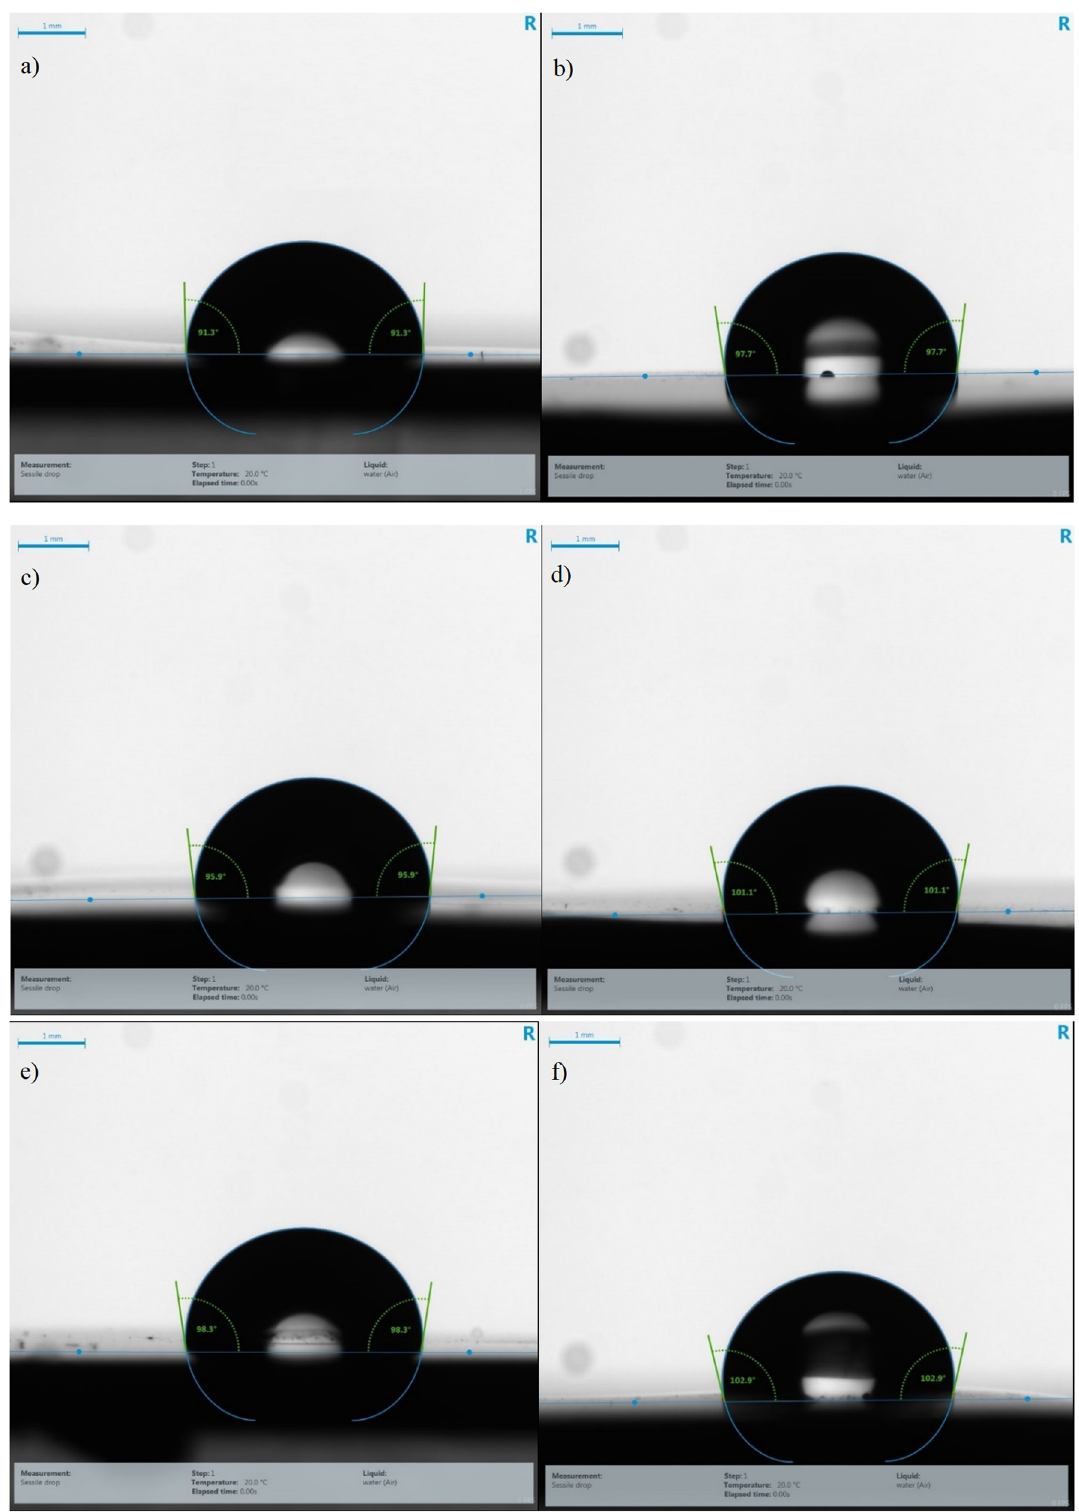
Figure 7: Contact angle images: unaged binder ( a ) without CSNPs and ( b ) with CSNPs; short - term aged binder ( c ) without CSNPs and ( d ) with CSNPs; long - term aged binder ( e ) without CSNPs and ( f ) with